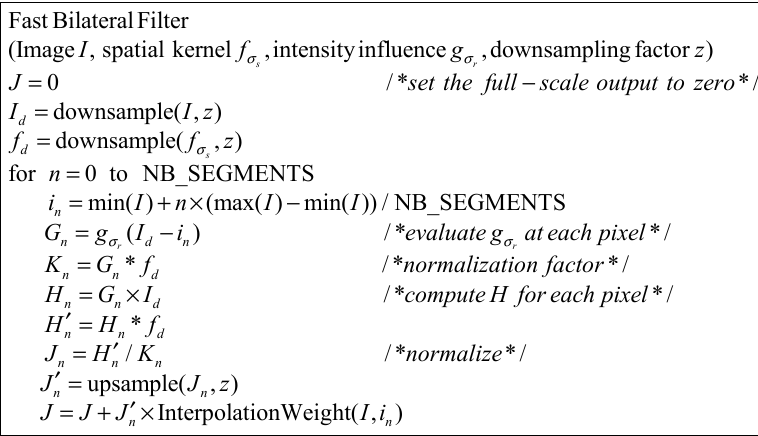
Figure 2. Pseudo code of the fast-bilateral filter (FBF).